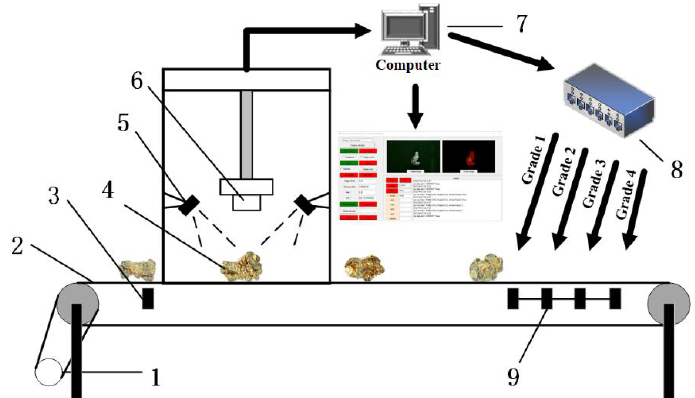
Figure 1. Panax notoginseng real-time sorting robot system. 1 — actuation system; 2 — conveyor belt;